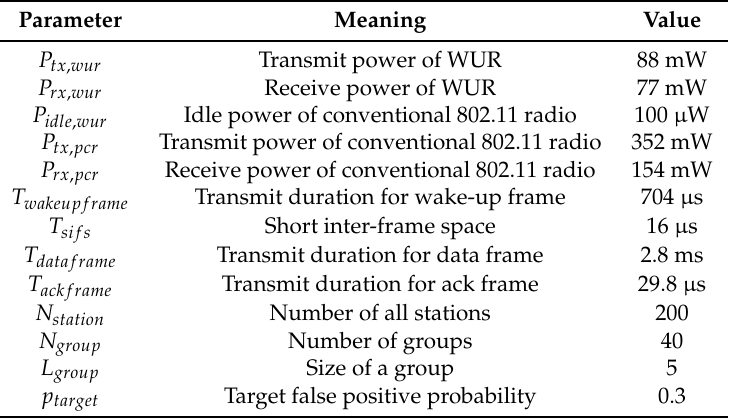
Table 1. Simulation parameters.